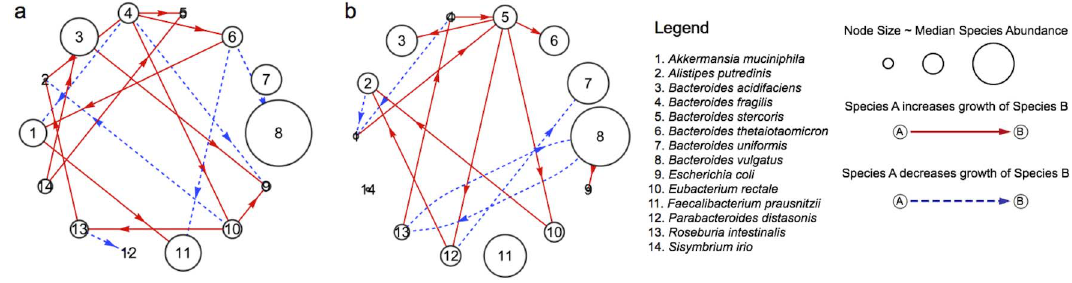
Figure 6. Interaction topologies of abundant species in the guts of two individuals. The size of a node denotes the median relative species abundance, beneficial interactions are shown as solid red arrows, and competetive interactions are shown as dashed blue arrows. In individual a) species 4 Bacteroides fragilis acts as a keystone species with 6 outgoing interactions, compared to a median number of outgoing interactions of 1 . In individual b) species 5 Bacteroides stercosis acts as a keystone species with 4 outgoing interactions, compared a median number of outgoing interactions of 1 . The 14 species included in the model were obtained by taking the union of the top 10 most abundant species from individuals a and b. The required improvement in prediction was set to 3%, graphs obtained using other prediction thresholds are shown in the Supporting Information.